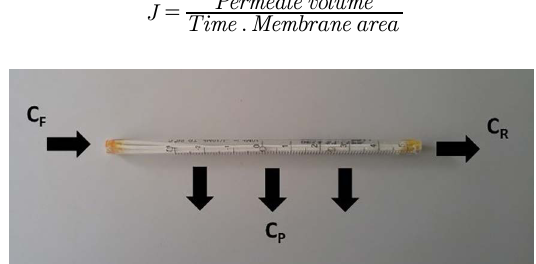
Figure 2 . Membrane module with five hollow fiber membranes inside. C , C and C indicate feed, permeate and rejection concentrations, F P R respectively.